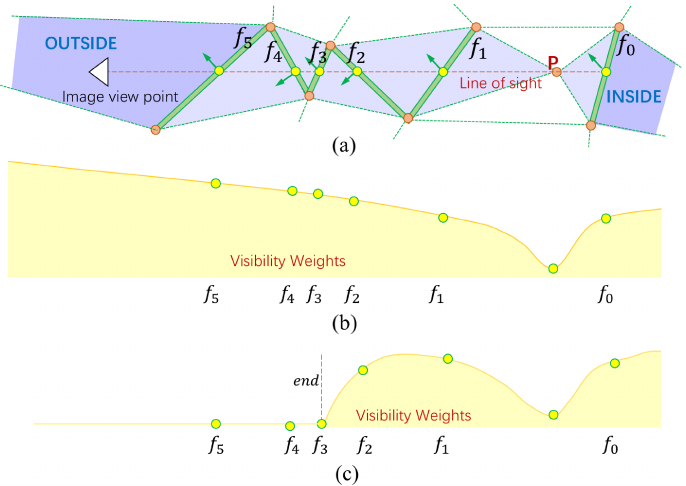
Figure 5. Illustration of our visibility weight strategy: ( a ) A line of sight from the camera center of an image view traverses a sequence of tetrahedra to a 3D point to accumulate the visibility weighted smooth terms. ( b ) The visibility weights proposed by [58]. ( c ) The visibility weights by our strategy, which are stopped by the end